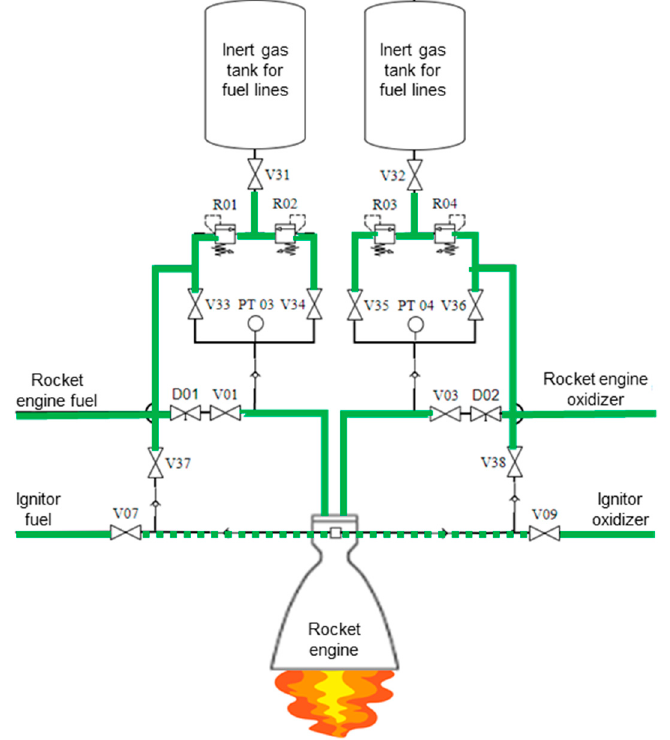
Figure 29. Algorithm’s 11th step diagram.